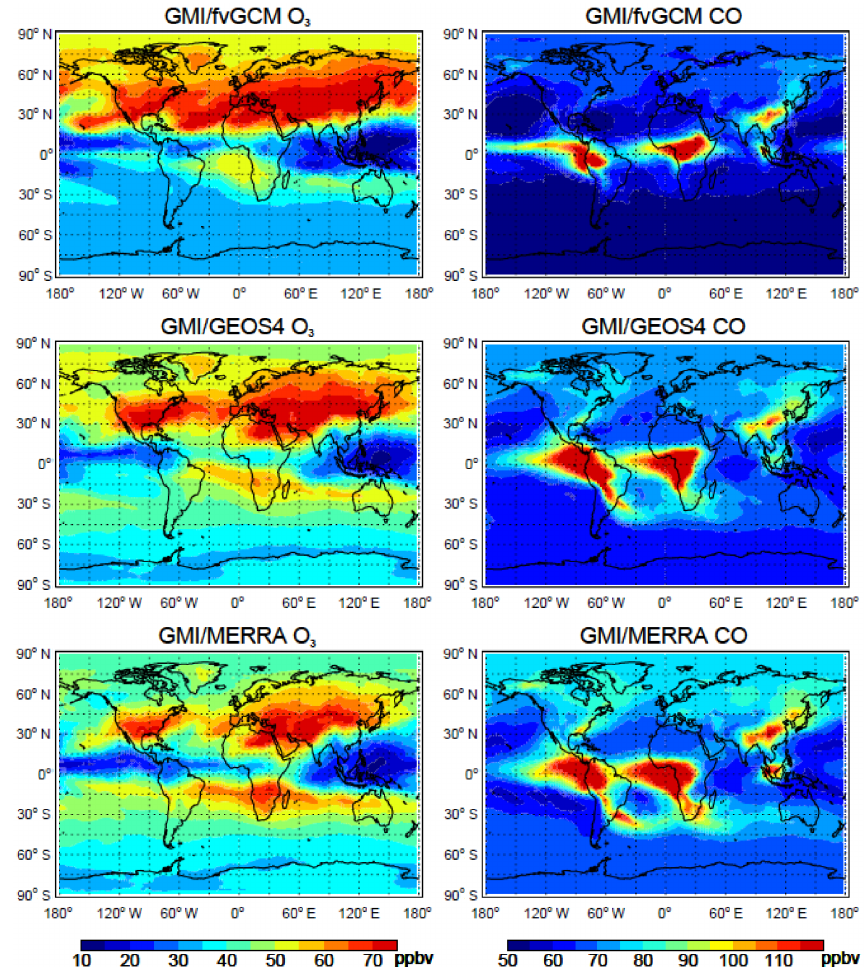
Figure 8. July–August mean mixing ratios of O 3 and CO (ppbv) at 618hPa as simulated by the GMI CTM driven by three meteorological data sets (1995 for fvGCM, 2005 for GEOS-4 and